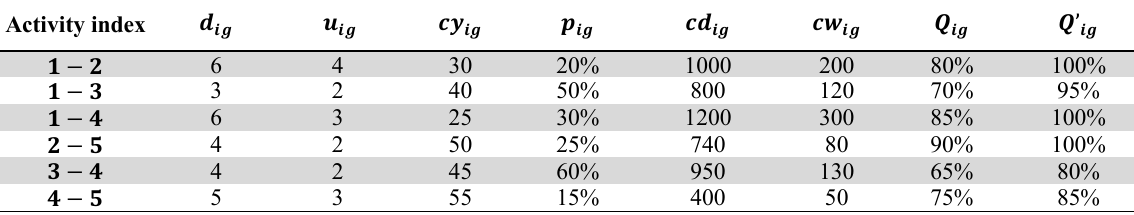
The project’s initial inputs